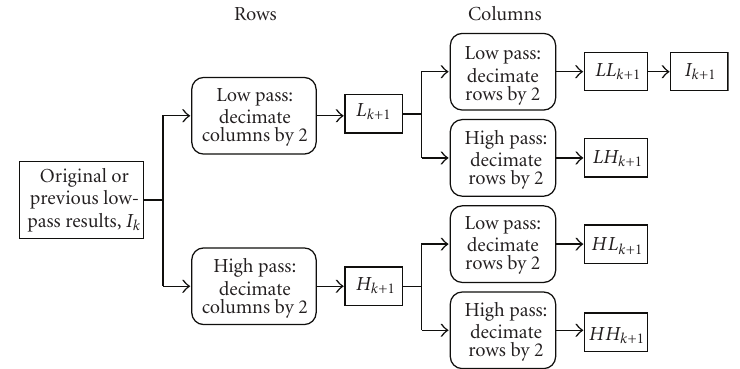
Figure 6: DWT decomposition of an image.